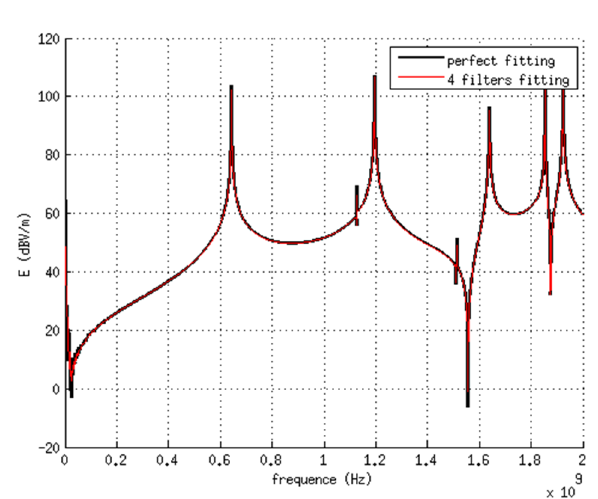
Figure 9. Field in the enclosure for a perfect and a 4 filters fitting of the surface